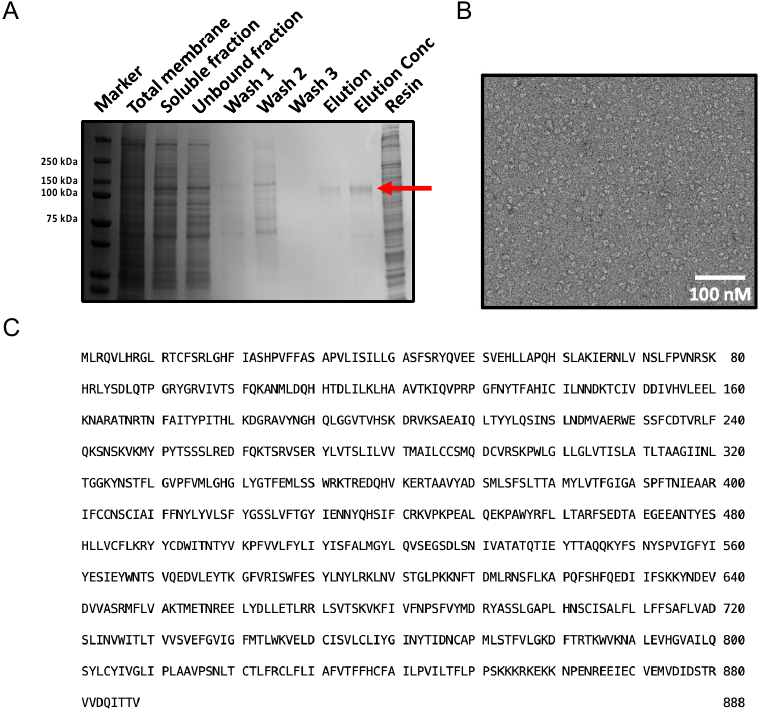
Figure 3. Optimised PTCHD1 purification. ( A ) SDS-PAGE shows a clear band corresponding to the 101 kDa size of PTCHD1. ( B ) A representative EM image of negatively stained, purified PTCHD1 at 25k magnification shows evenly distributed homogeneous particles. ( C ) Highlighted residues of PTCHD1 were identified by mass spectrometry following purification.